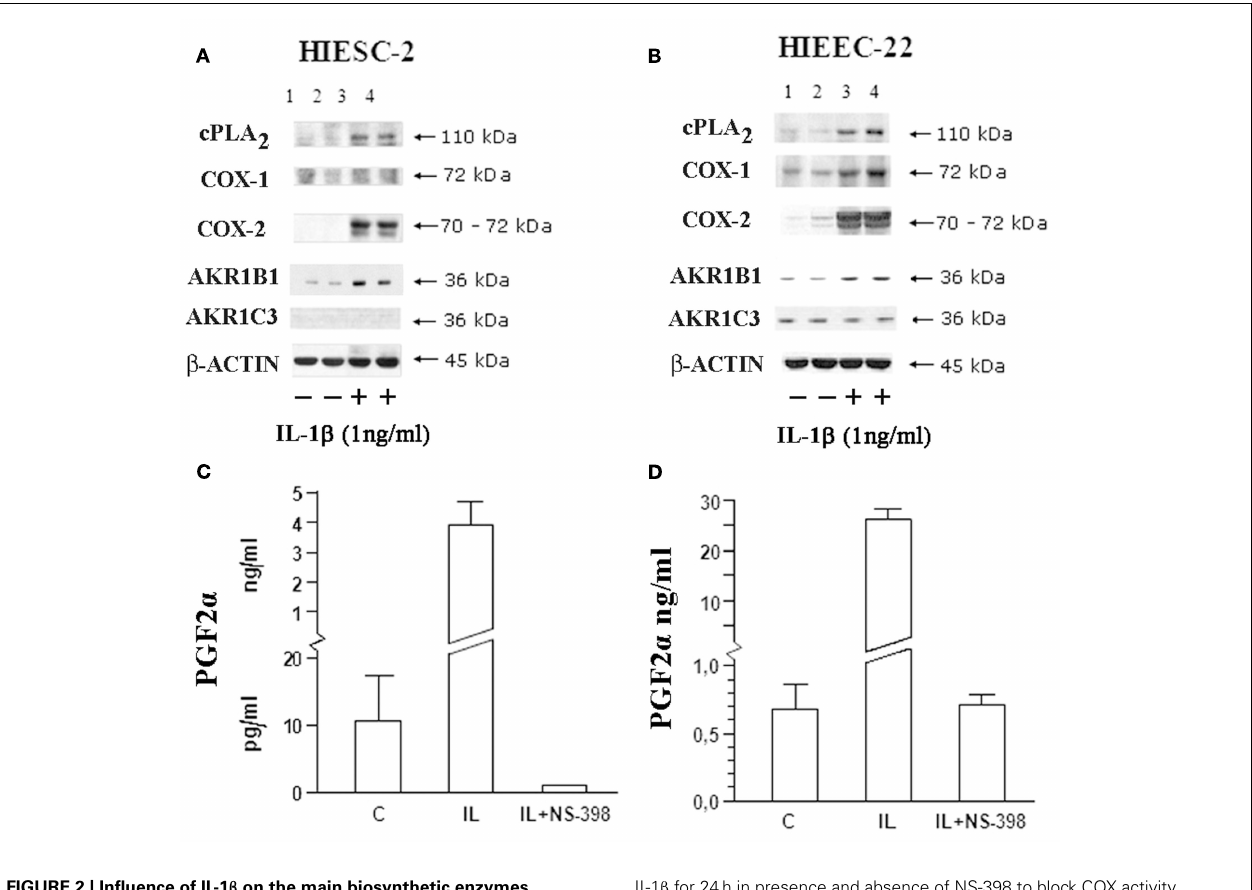
FIGURE 2 | Influence of IL-1 β on the main biosynthetic enzymes associated with PGF2 α production in human endometrial stromal and epithelial cells. Human endometrial stromal (HIESC-2) and epithelial (HIEEC-2) cells were grown to confluence and treated with